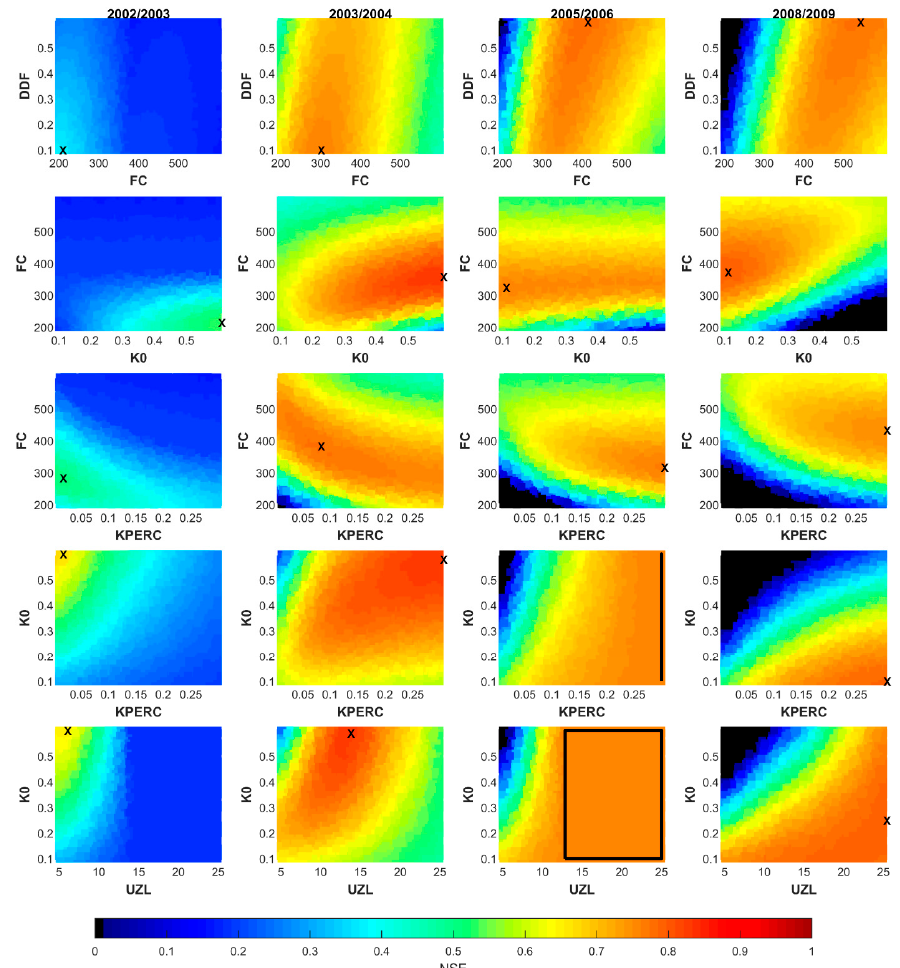
Figure 8. Scatter plots of the five parameter couples FC-DD, FC-K0, FC-KP, K0-KP, and K0-UZL classified according to the NSE values. The X marker refers to the best-performing pair of parameter values. The continuous black lines enclose the combinations of parameter values that result in the same NSE